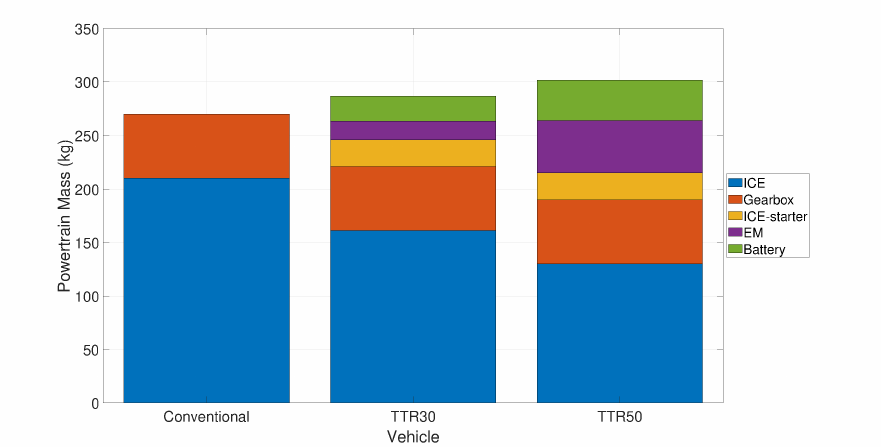
Figure 4. Weight distribution of the powertrain components optimized with the Optimal Layout Tool [31].